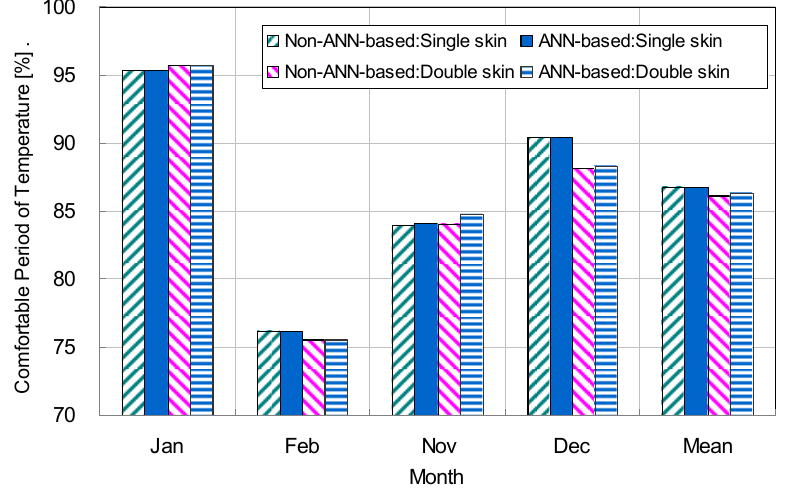
Figure 13. Comfortable period of indoor air temperature by four control